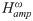
Simulation for CD model over universality classes.DCCA correlation coefficients and Hurst exponent for the simulated CD model. The x-axis denotes the exponent α and the y-axis denotes β. The black lines denotes the transitions in meta-universality class according to the theory. In each case the colour on the image and colourbar corresponds to the quantity in the subtitle (e.g. in the left hand image the colour corresponds to Hampω.) The details of the simulation are given in Section: Results: Predictions for all Meta-Universality Classes.